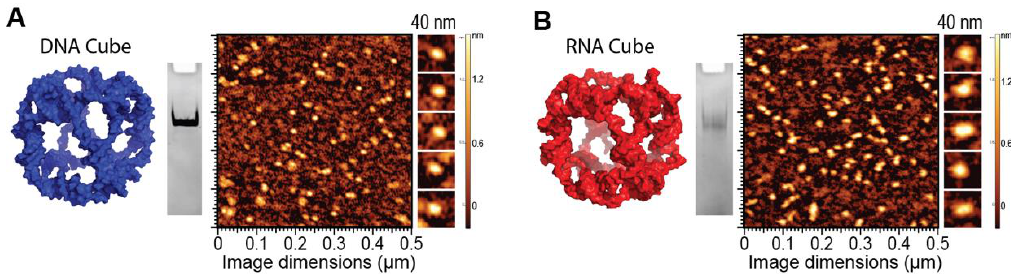
Figure 2. DNA and RNA cube characterization. 3D models, native-PAGE results, and representative AFM images of ( A ) DNA cubes and ( B ) RNA cubes.